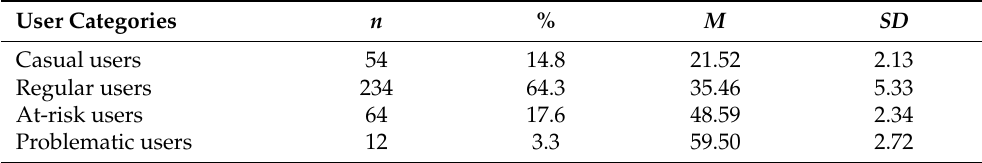
Table 6. Percentage of users based on category.